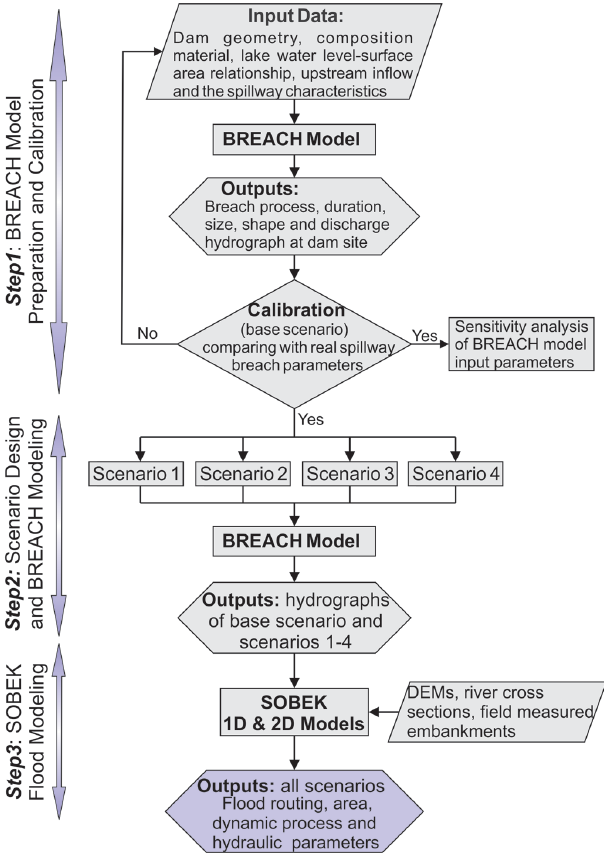
Fig. 6. Flowchart of the integrated simulation